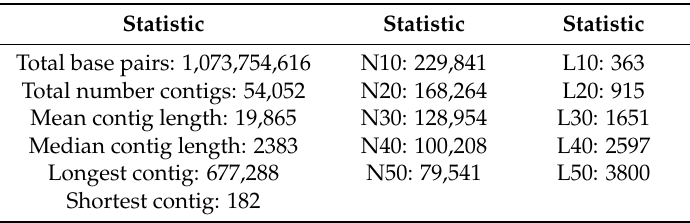
Table 2. Genome assembly